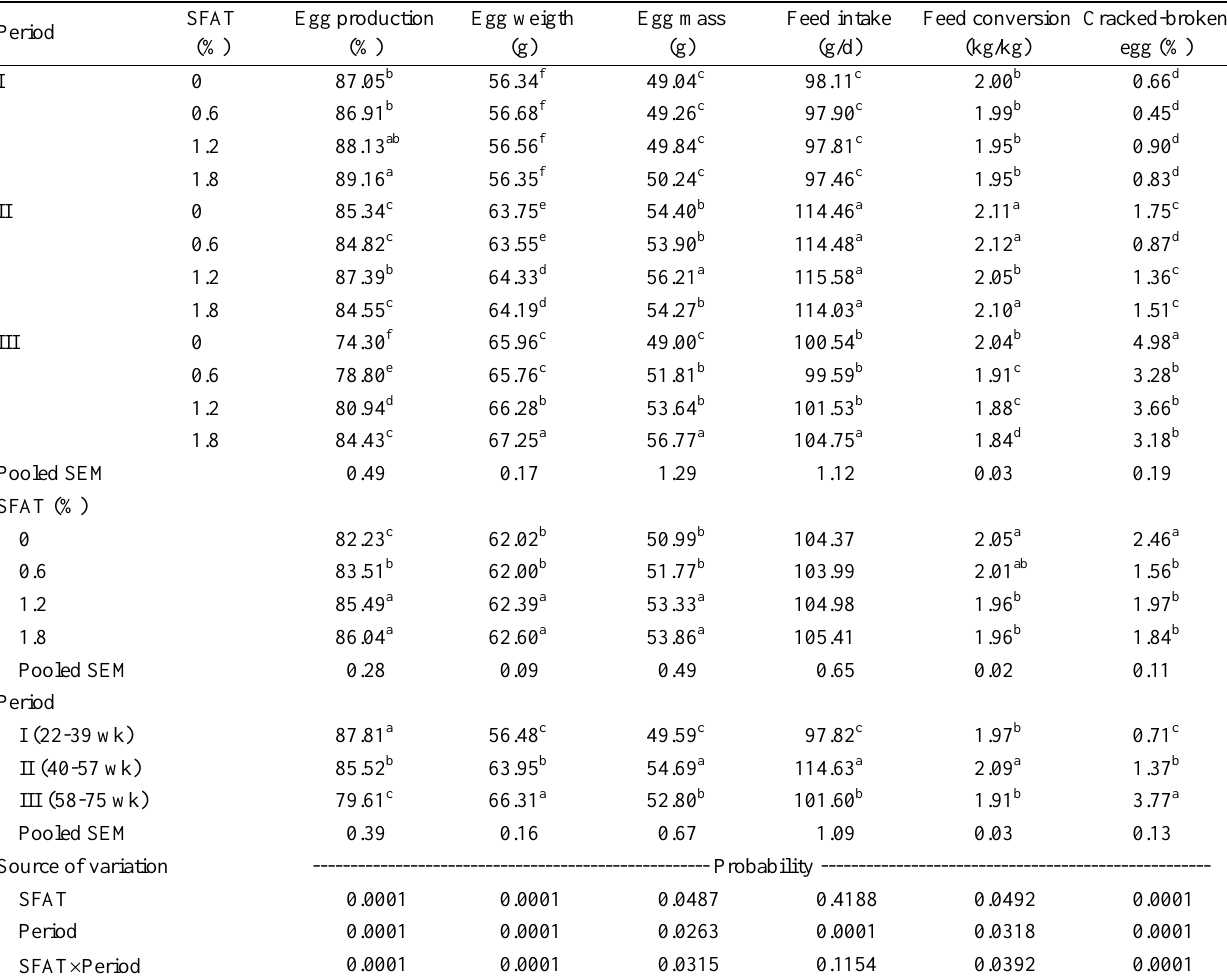
Table 4. Effects of SFAT on productive performance of layer hens